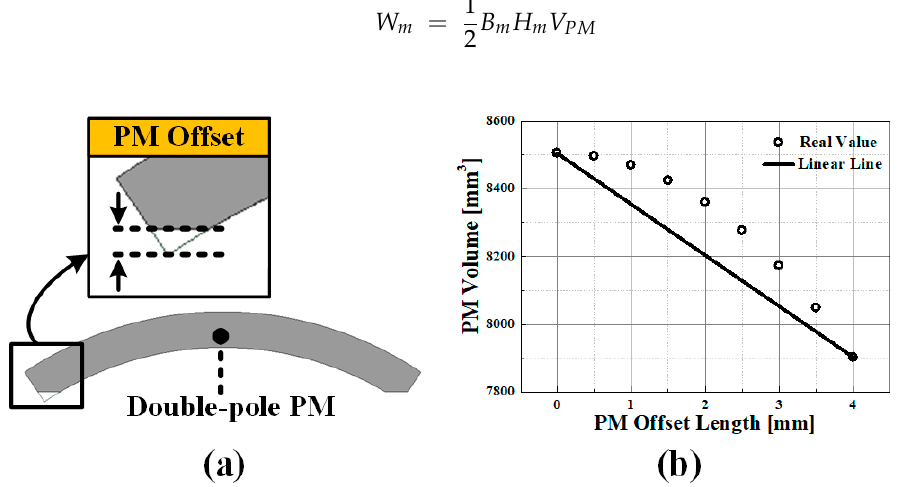
Figure 4. ( a ) PM offset and ( b ) relationship of the PM offset length and PM volume in the double-pole PM.